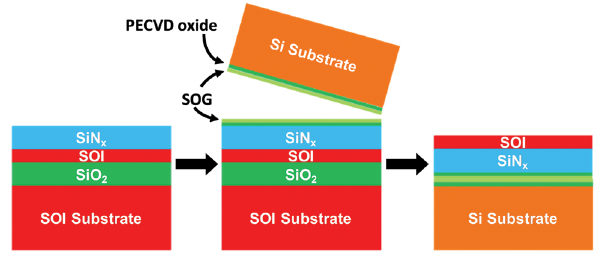
Figure 10 Four different mid-infrared waveguide technologies pursued at CREOL, their schematics and their measured propagation losses: (A) silicon-on-sapphire (SOS) (unpublished); (B) silicon-on-nitride (SON) [199]; (C) all-silicon optical platform (ASOP) [200]; (D) silicon-on- lithium-niobate (SiLN) [201, 202].